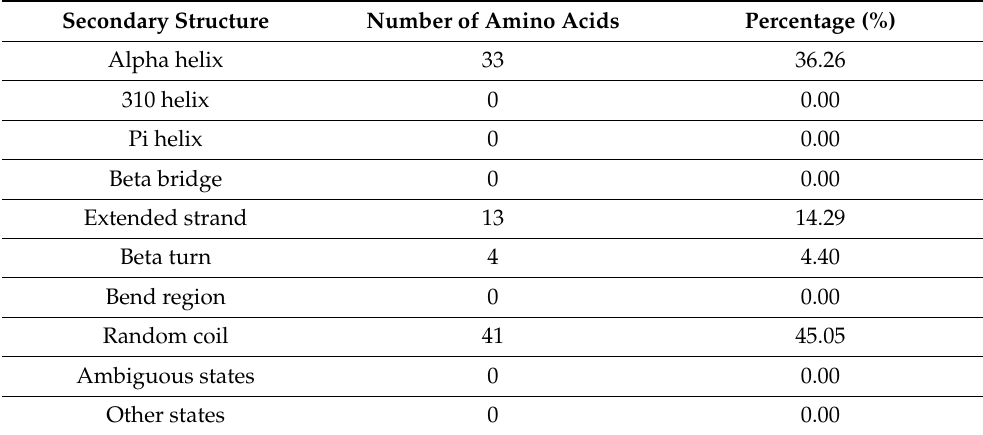
Table 5. Percentage of secondary structures of AChE1 predicted using